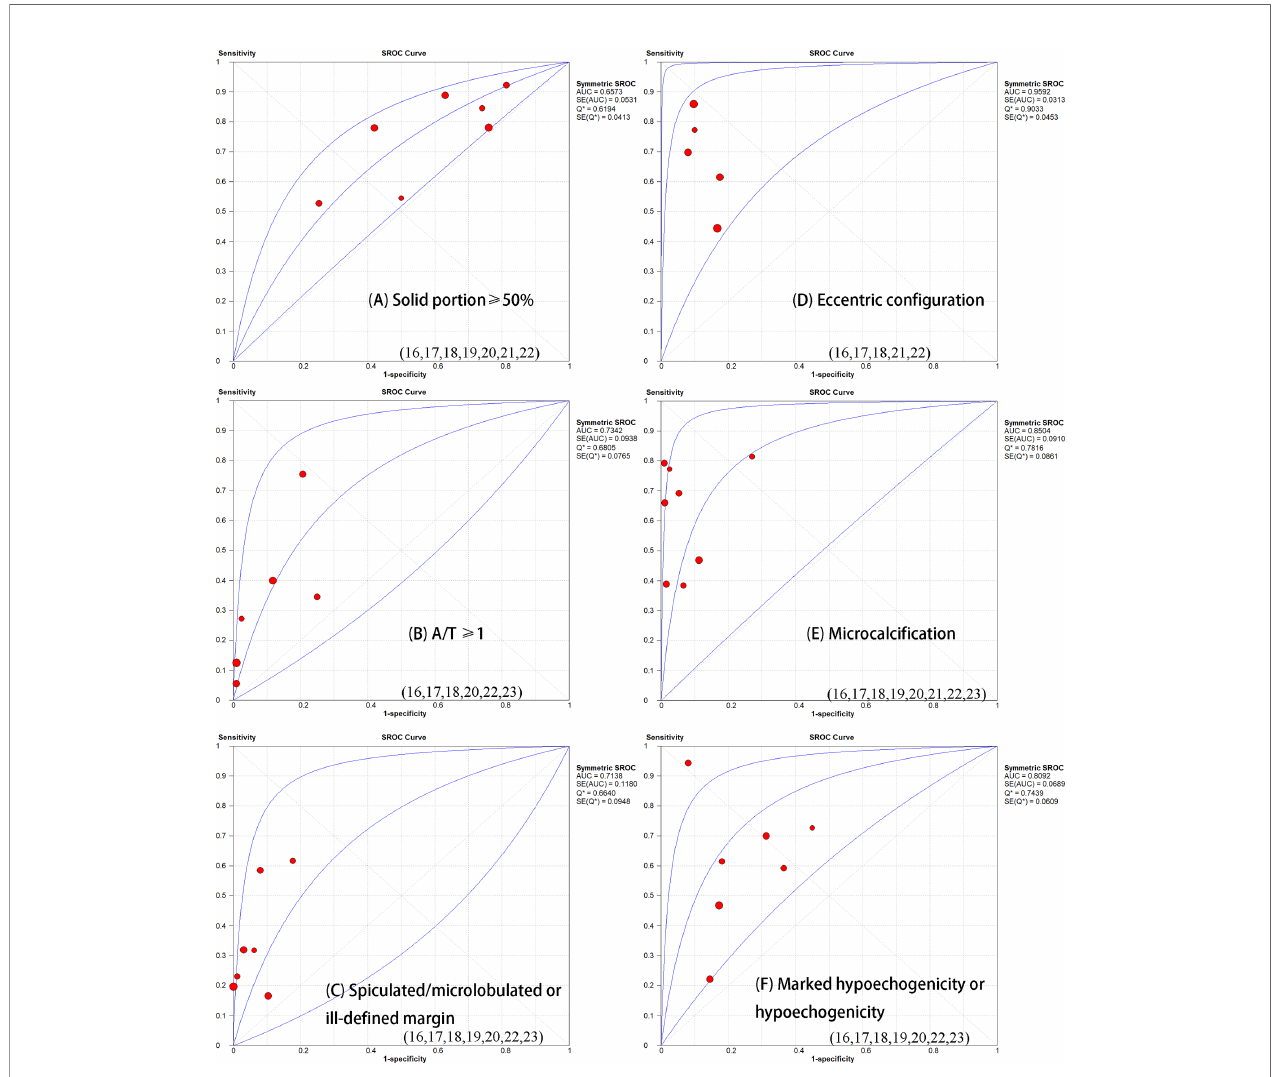
FIGURE 5 | Summary receiver operator characteristic curve (SROC) with area under the ROC curve (AUC) of six sonographic features in diagnosing partially thyroid cancer. The size of each study is indicated by the size of the solid circles. PCTNs with an eccentric con fi guration are more prone to malignancy